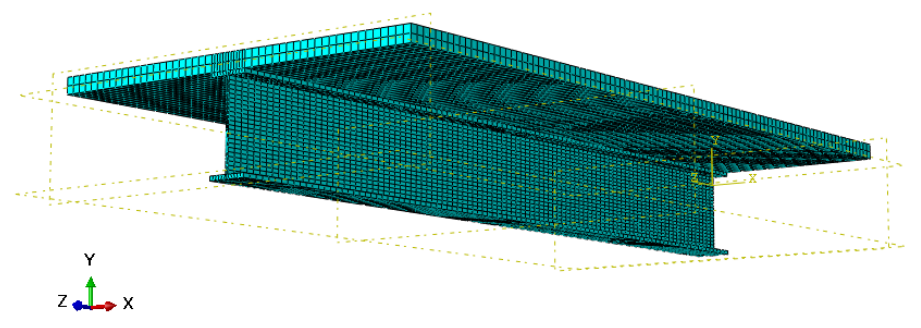
Figure 11. Finite elements mesh density